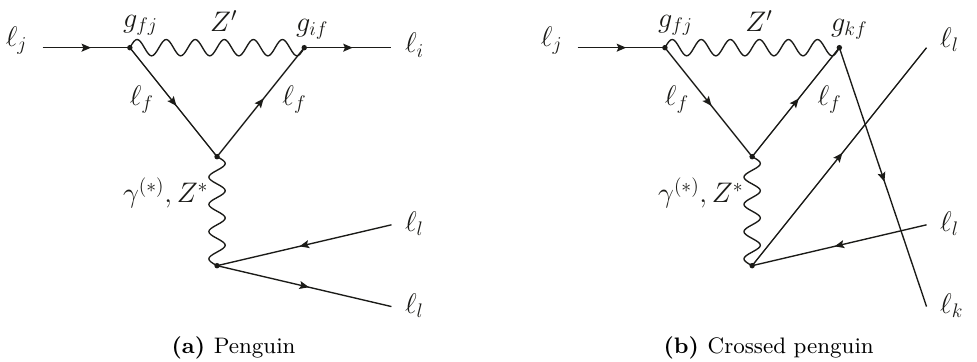
Figure 2. Feynman diagrams showing the Z - and the photon-penguin contributions to ‘ j → ‘ i ‘ l ‘ k −